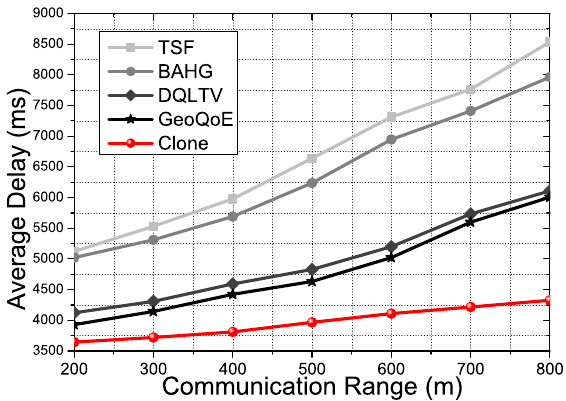
Figure 14. Average delay for communication range and average density rate.